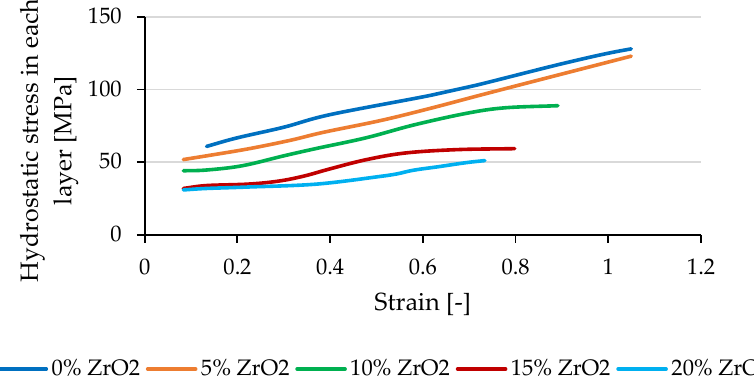
Figure 15. Calculated hydrostatic stresses in each layer of the specimens at the same pressure load [41].